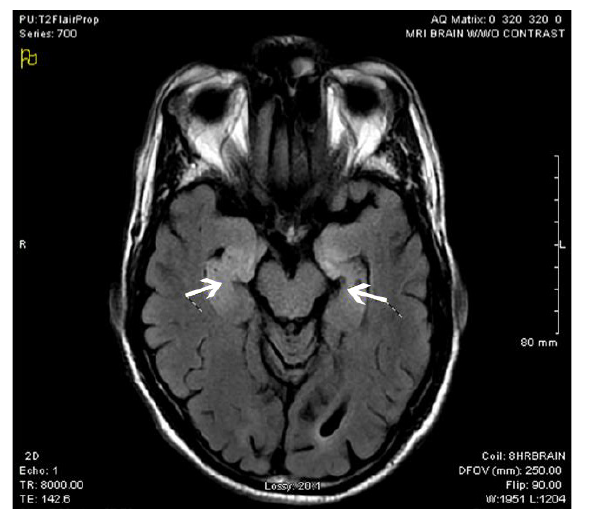
Image 2. Axial T2 FLAIR sequence magnetic resonance imaging showing enhancement of the medial temporal lobe (arrows). FLAIR, fluid attenuated inversion